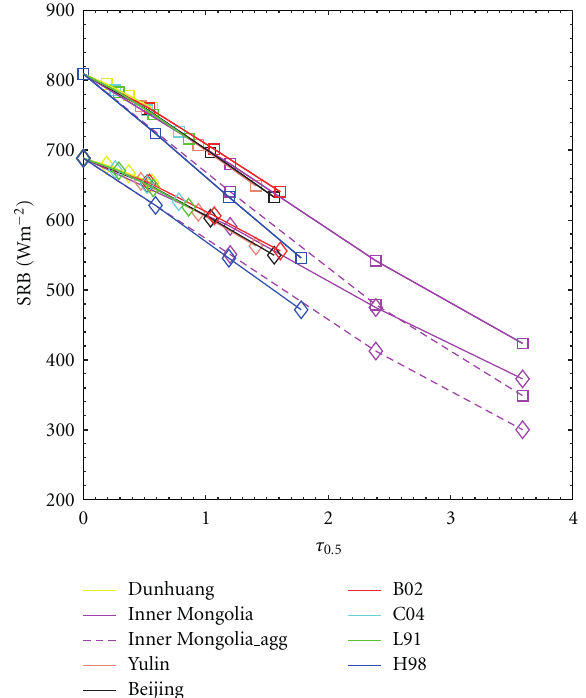
Figure 8: Surface radiative balance (SRB) over the cropland-2 (squares) and grassland (diamonds) for considered dust cases (at three dust